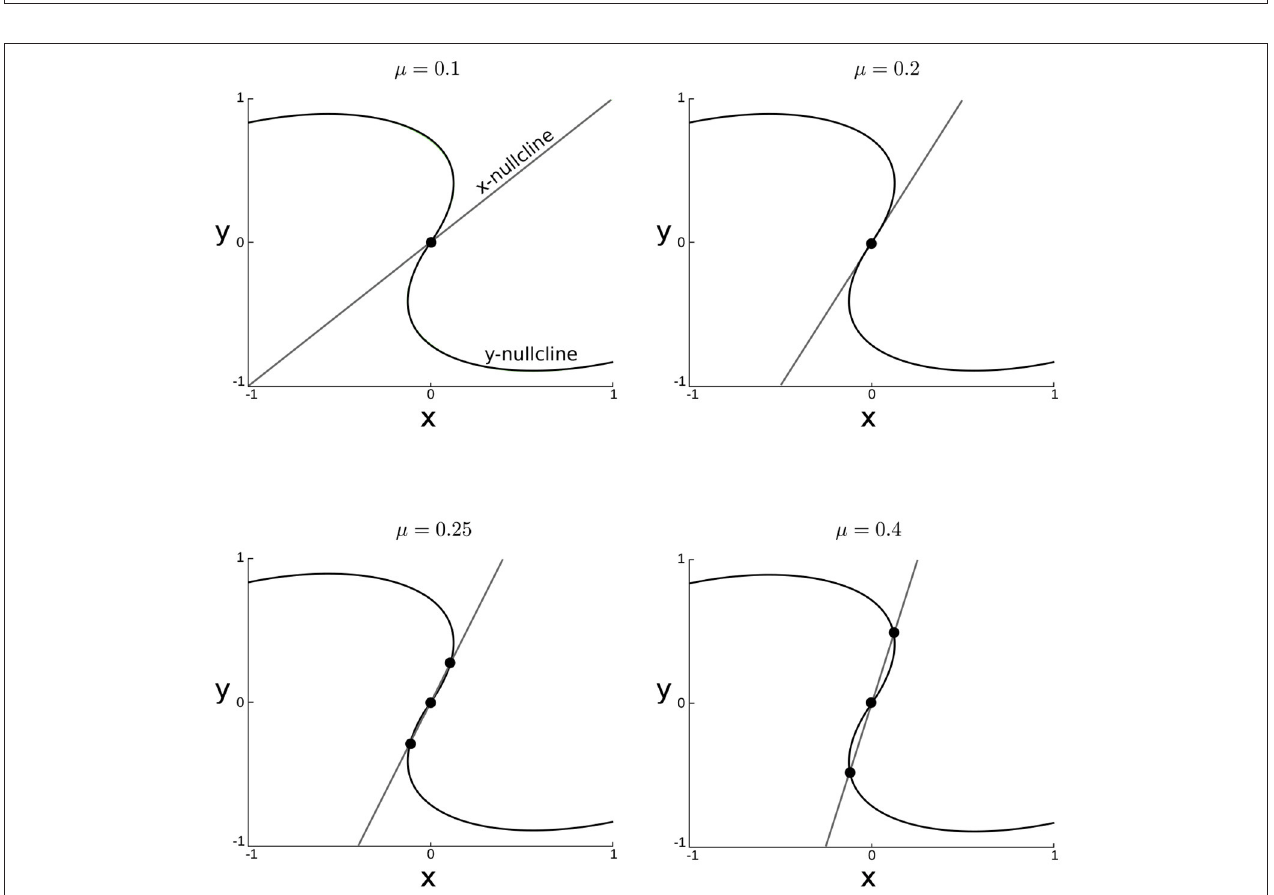
0.5, N 20, natural frequencies uniformly distributed in the interval [0.9,1.1] and varying µ . The = = 0.25 both oscillatory and oscillator death states are possible. =